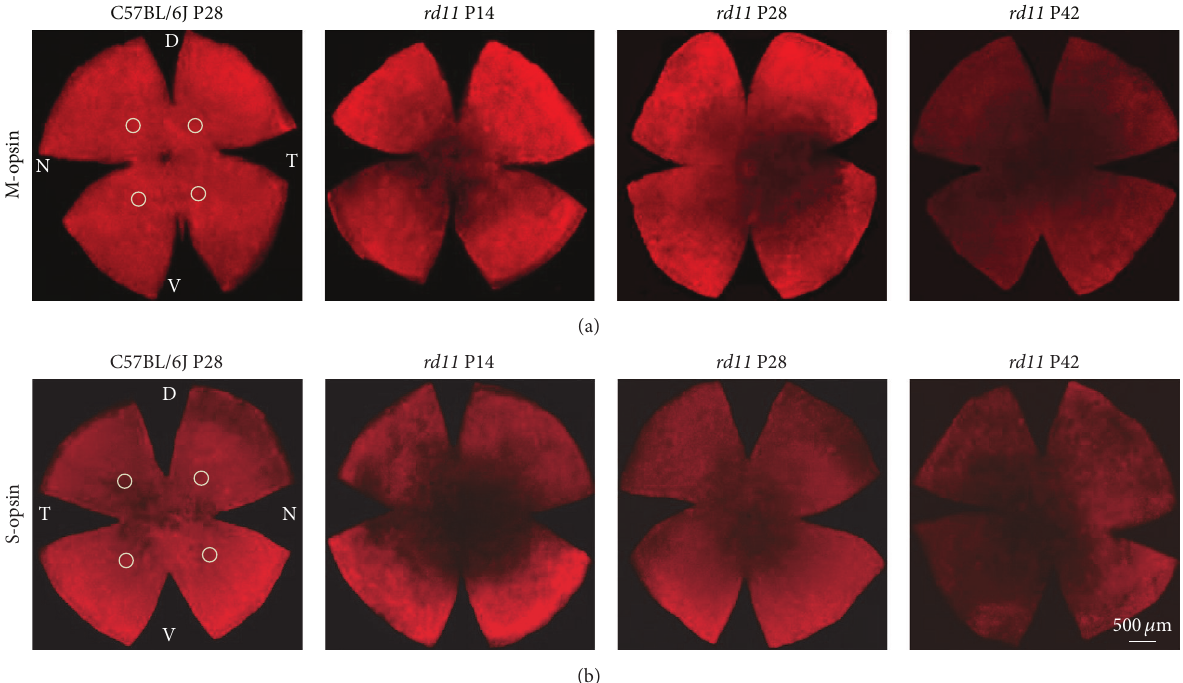
Figure 1: Immunofluorescence staining of L- and S-opsin in retinal whole mounts (Cy3 × 25). (a) Representative L-opsin staining in the right eye of C57BL/6J control and P14, P28, and P42 rd11 mice; (b) representative S-opsin staining in the left eye of the same C57BL/6J control and P14, P28, and P42 rd11 mice. D: dorsal; V: ventral; N: nasal; T: temporal. 𝑛 = 5 retina per